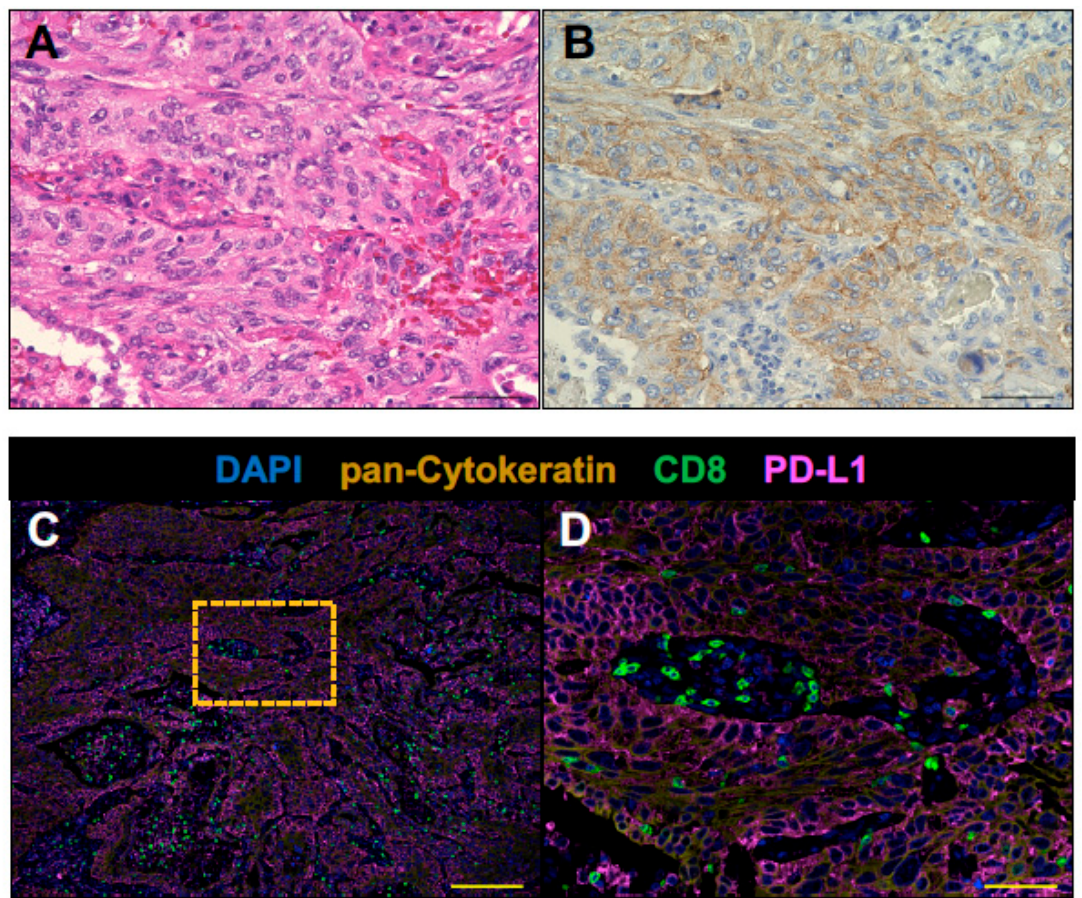
Figure 2. CD8+ T cells infiltrate pretreatment lung tumor of the anti-AChR Ab-seropositive NSCLC patient who achieved a CR to nivolumab. The surgically resected tumor was analyzed by fluorescent multiplex immuno-histochemistry. Serial formalin-fixed paraffin-embedded (FFPE) sections of the tumor sample were stained with Haematoxylin and Eosin ( A ), PD-L1 IHC 22C3 pharmDx ( B ) and analyzed by fluorescent multiplex immunohistochemistry ( C , D ). The panel ( D ) shows the boxed region in the panel ( C ) at high magnification. CD8+ T cells (green) were infiltrated into both tumor stroma and pan-Cytokeratin positive tumor cell nests (dark yellow). The tumor expressed PD-L1 (magenta). Nuclei were stained with DAPI (blue). Scale bars, 50 µ m ( A , B , and D ) and 200 µ m ( C ), are shown in each panel.